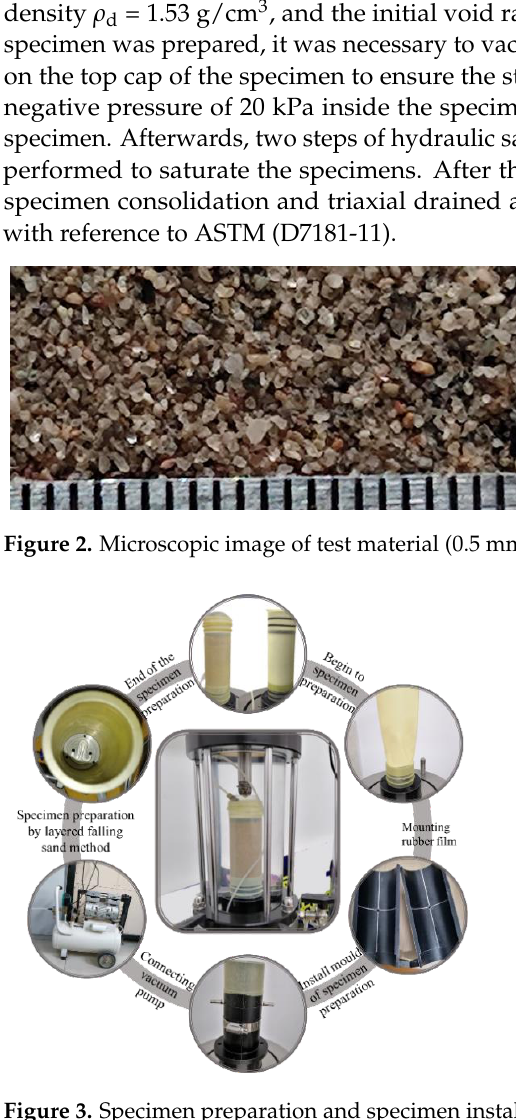
Figure 2. Microscopic image of test material (0.5 mm/grid).